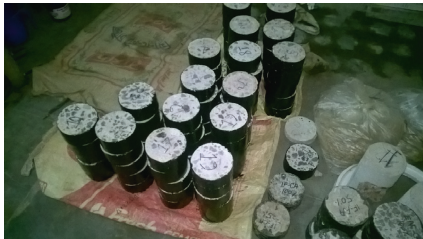
Figure 8: Specimens prepared for RCPT test.